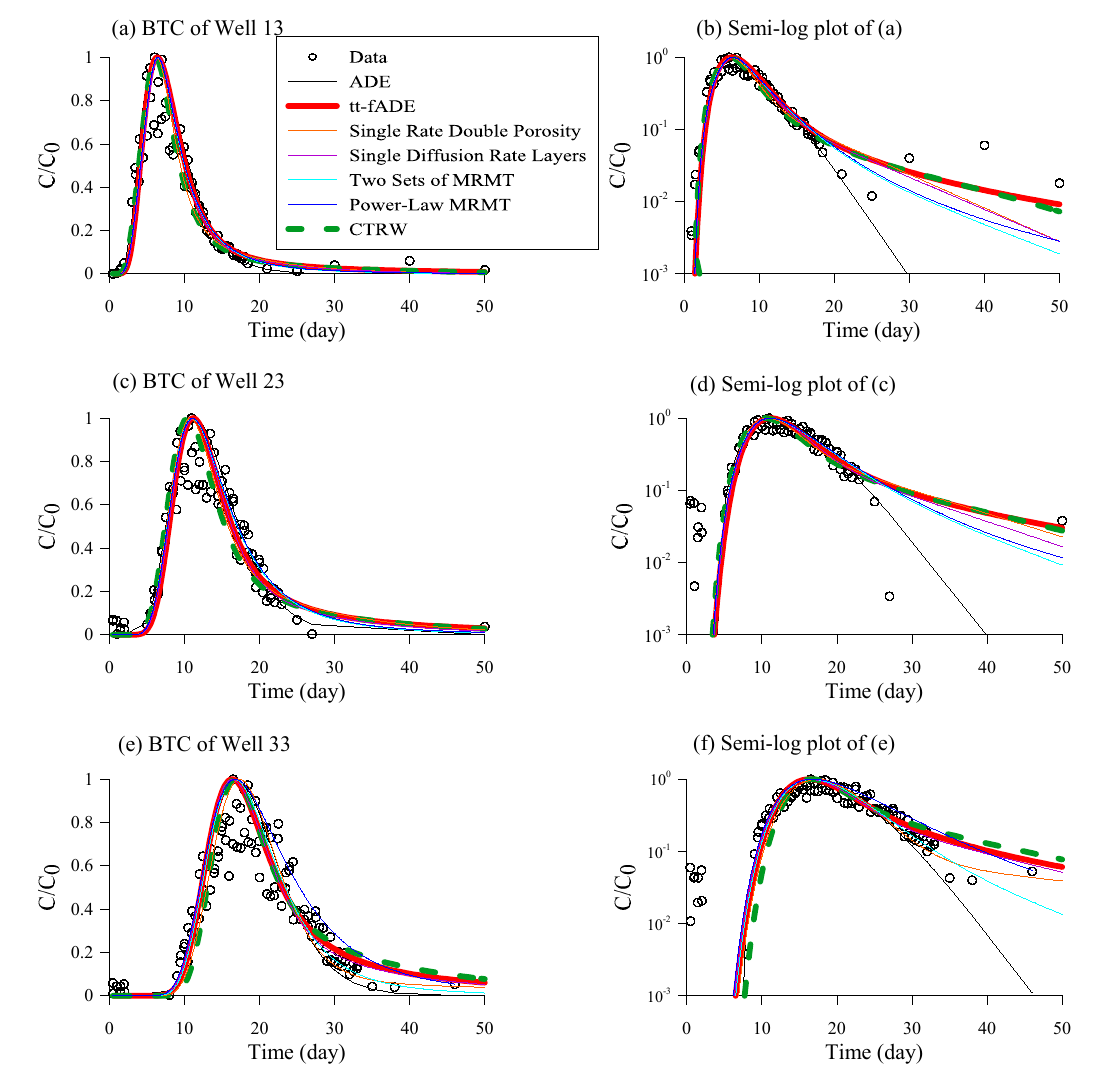
Figure 9. Field tracer test: comparison between the measured field data (symbols) and the modeled (lines) breakthrough curves using the ADE, the tt-fADE (red thick lines), the CTRW (green dashed lines), and the MRMT models.